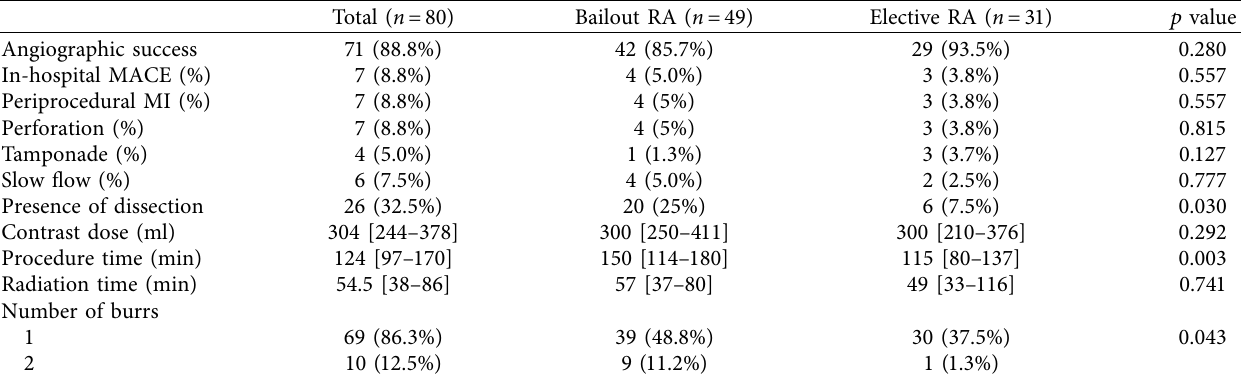
Table 6: Periprocedural complications and in-hospital outcomes after bail-out versus elective RA within the CTO group.